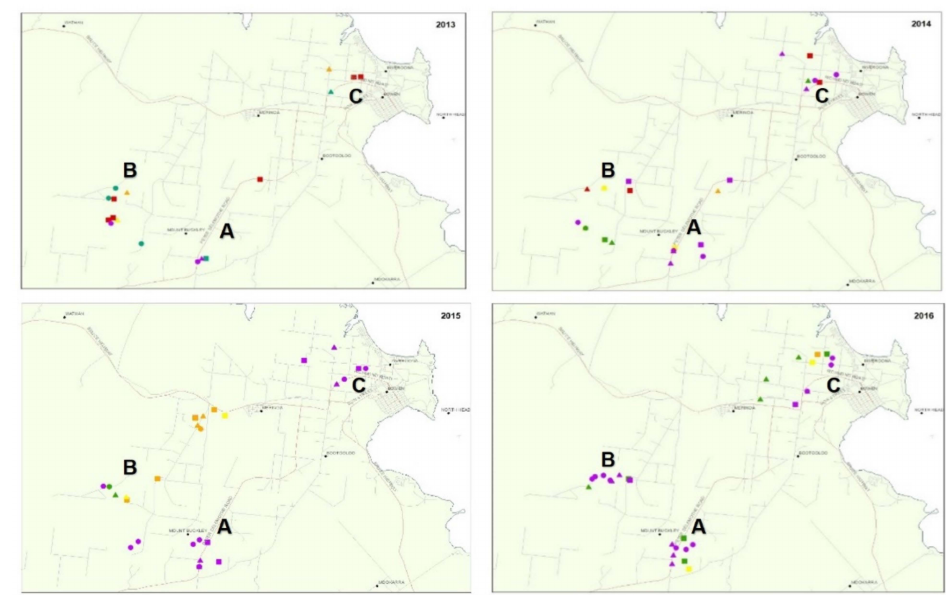
Figure 1. Distribution and severity of tomato yellow leaf curl virus (TYLCV) in the study area from 2013–2016. The three distinct survey areas are denoted as A, B, and C. Survey time points during the season are depicted as early = dot, mid = triangle, and late = square and TYLCV incidence in crops (shown as a percentage in brackets) by colour with no virus = purple, low (0.1–5%) = green, mod (5.1–10%) = yellow, high (10.1–30%) = orange and very high (>30%) =